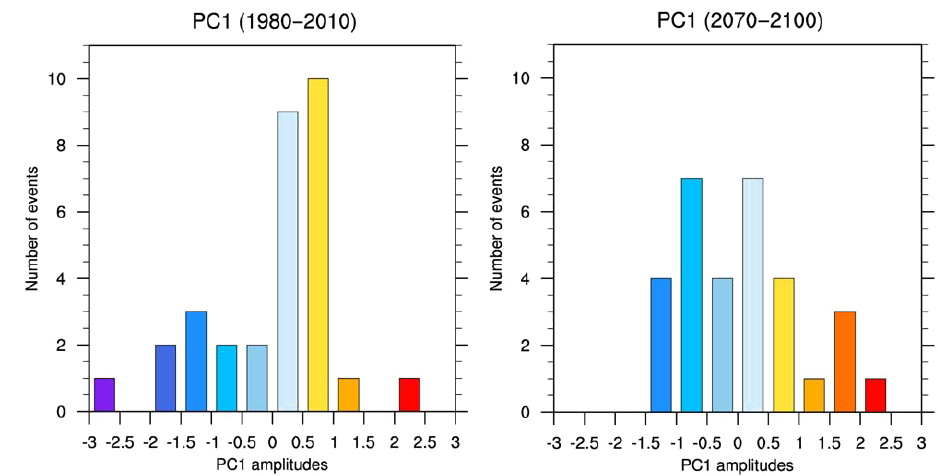
Figure 4. NAO phase number distributions, computed in the recent past (left) and future (right)